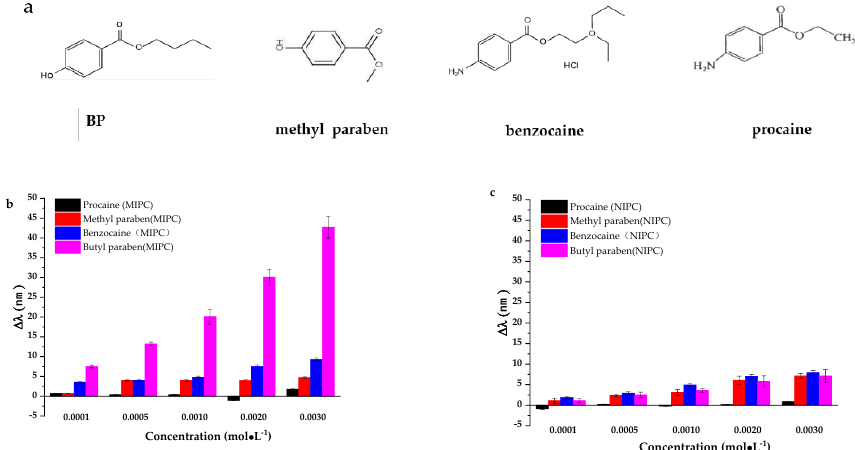
Figure 5. The chemical formula ( a ) of BP and structural analogues; comparison of the sensing effect of MIPC ( b ) and NIPC ( c ) film.